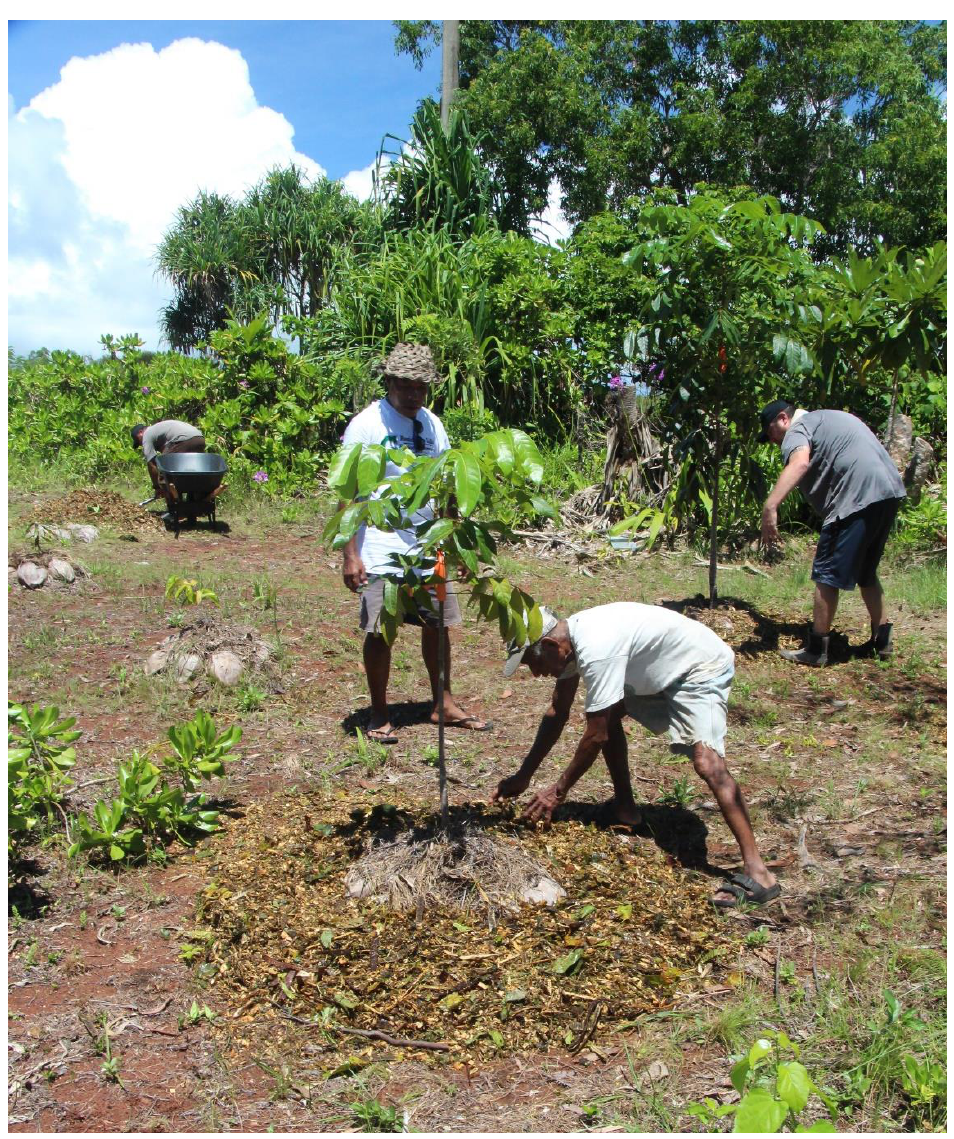
Figure 6. Fresh wood chip mulch applied to Swietenia macrophylla seedlings on Yap, Federated States of Micronesia.